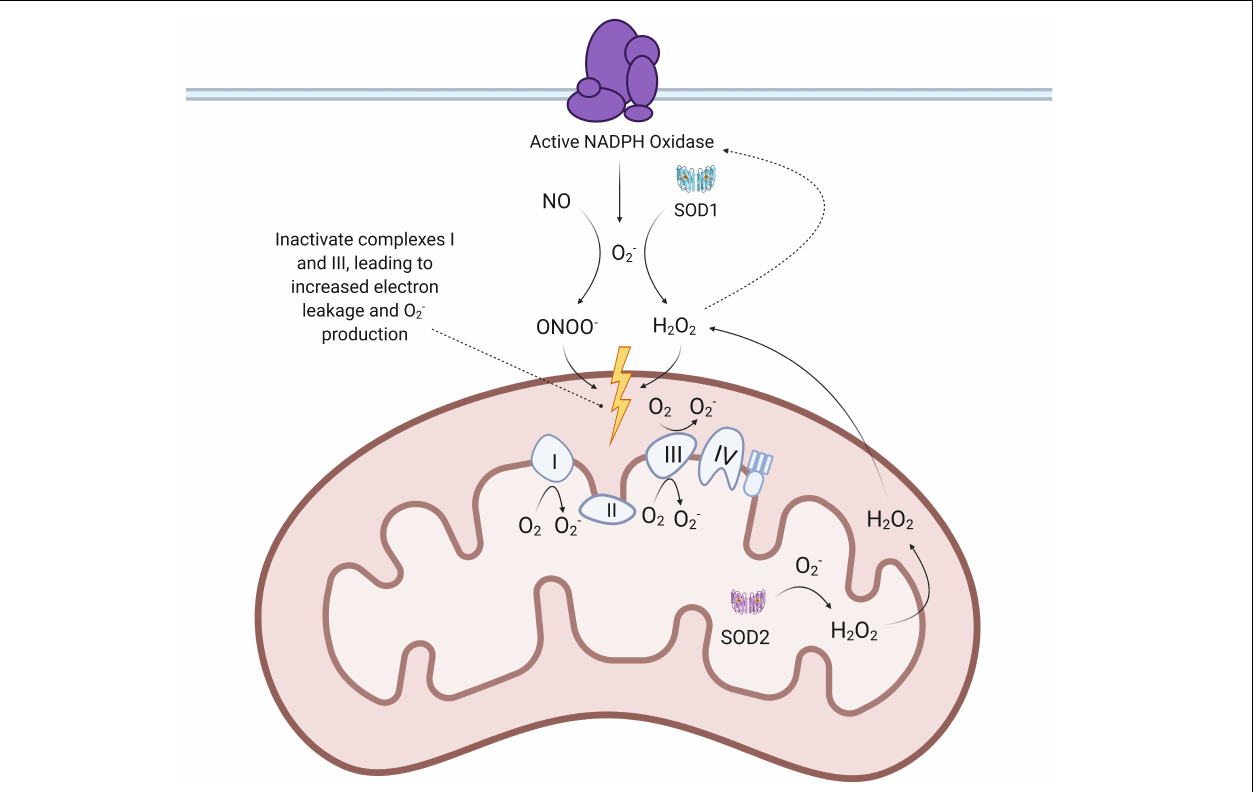
FIGURE 3 | Proposed mechanisms of SARS-CoV-2 mediated increase in mtROS production. When SARS-CoV-2 spike proteins bind to the ACE2 receptor to enter ECs, ADAM17 is thought to be activated and cleave the ACE2 ectodomain, leading to downregulation of ACE2. This leads to an accumulation of Ang II that binds to AT1R, a G-protein-coupled receptor. The binding of Ang II to AT1R activates downstream effectors like c-Src, PKC, and Rac-1, which facilitate assembly and activation of NADPH oxidase. NADPH oxidase produces O − 2 that reacts with NO to form ONOO − and is also converted to H 2 O 2 by SOD1. ONOO − and H 2 O 2 both inactivate ETC complexes, which results in increased production of O − 2 . Mitochondrial SOD2 can then convert O − 2 to H 2 O 2 , which is able to diffuse across membranes. TMPRSS2: transmembrane protease, serine 2; ACE: angiotensin-converting enzyme; ETC: electron transport chain; mtROS: mitochondrial